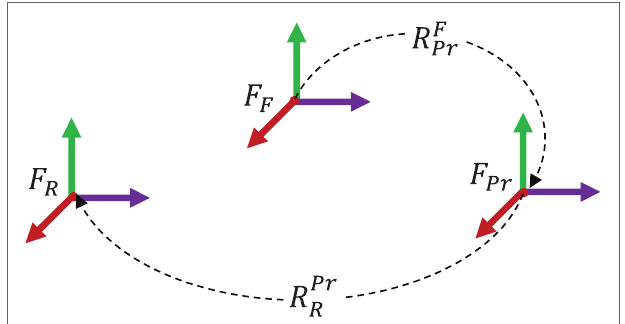
FIGURE 3 | Unconstrained cooperative control coordinate frames